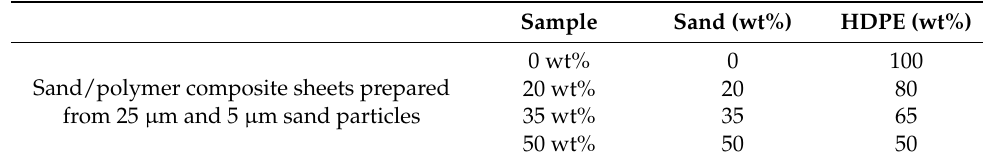
Figure 1. Experimental process. Table 1. Chosen weight percentages for sand, and HDPE.